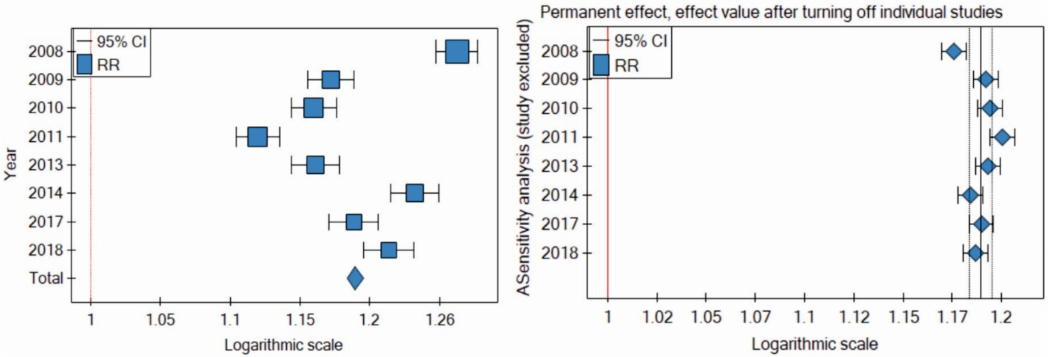
Figure 3. The relative risk of an accident at work among workers aged 20–29 years employed in Poland (own elaboration).